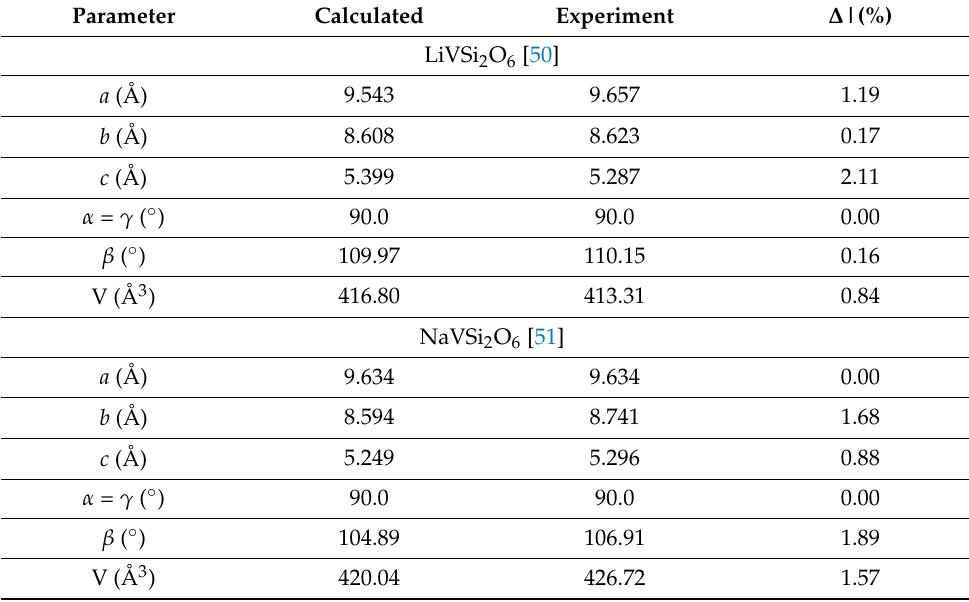
Table 2. Calculated and experimental lattice parameters of bulk LiVSi 2 O 6 and NaVSi 2 O 6 .